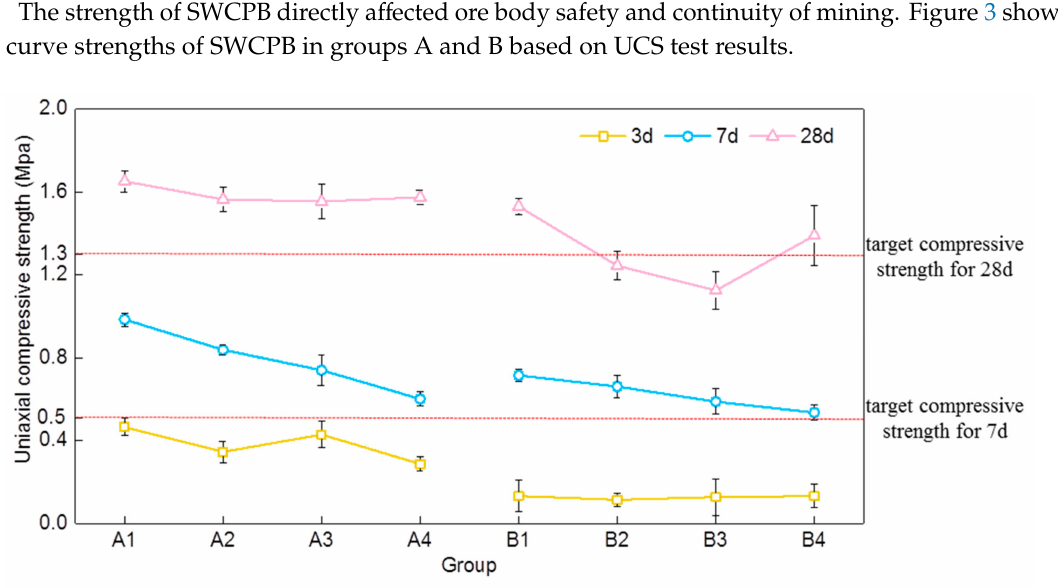
Figure 3. UCS comparison of di ff erent mixture ratios of groups A and